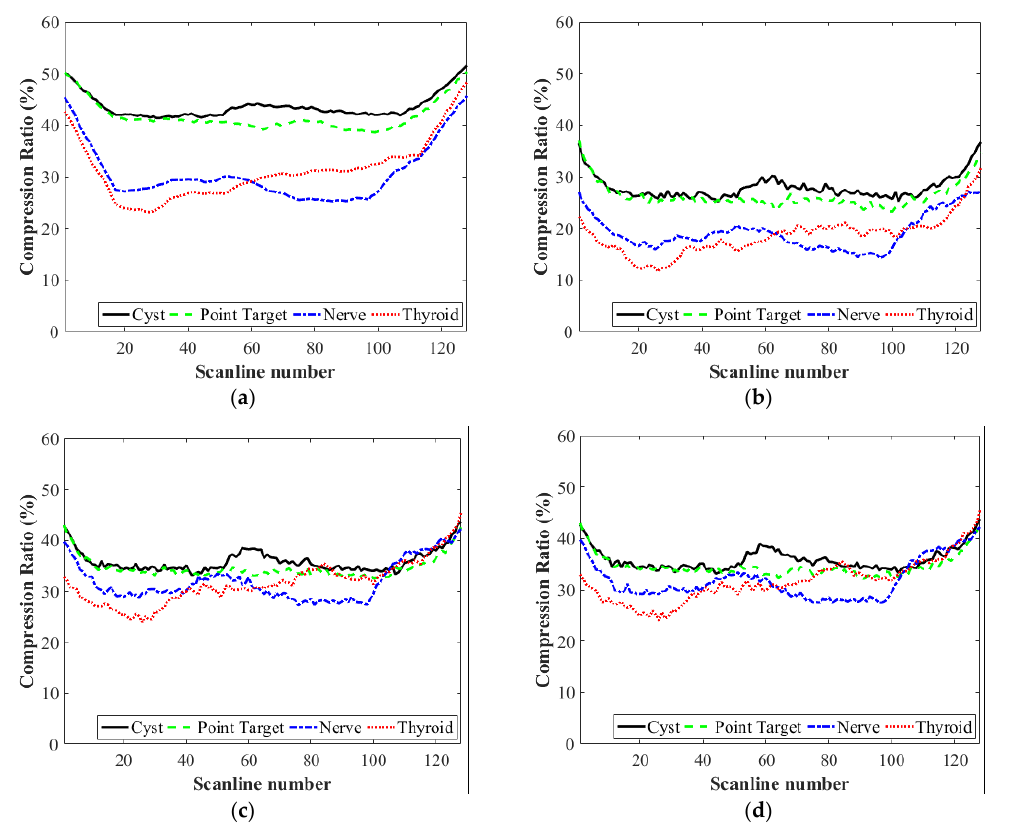
Figure 4. Compression ratios (%) of ( a ) pre-beamformed, ( b ) beamformed, ( c ) inphase (I), and ( d ) quadrature (Q) data that were used to construct the images of point targets, cysts, nerve, and thyroid in Figure 3.